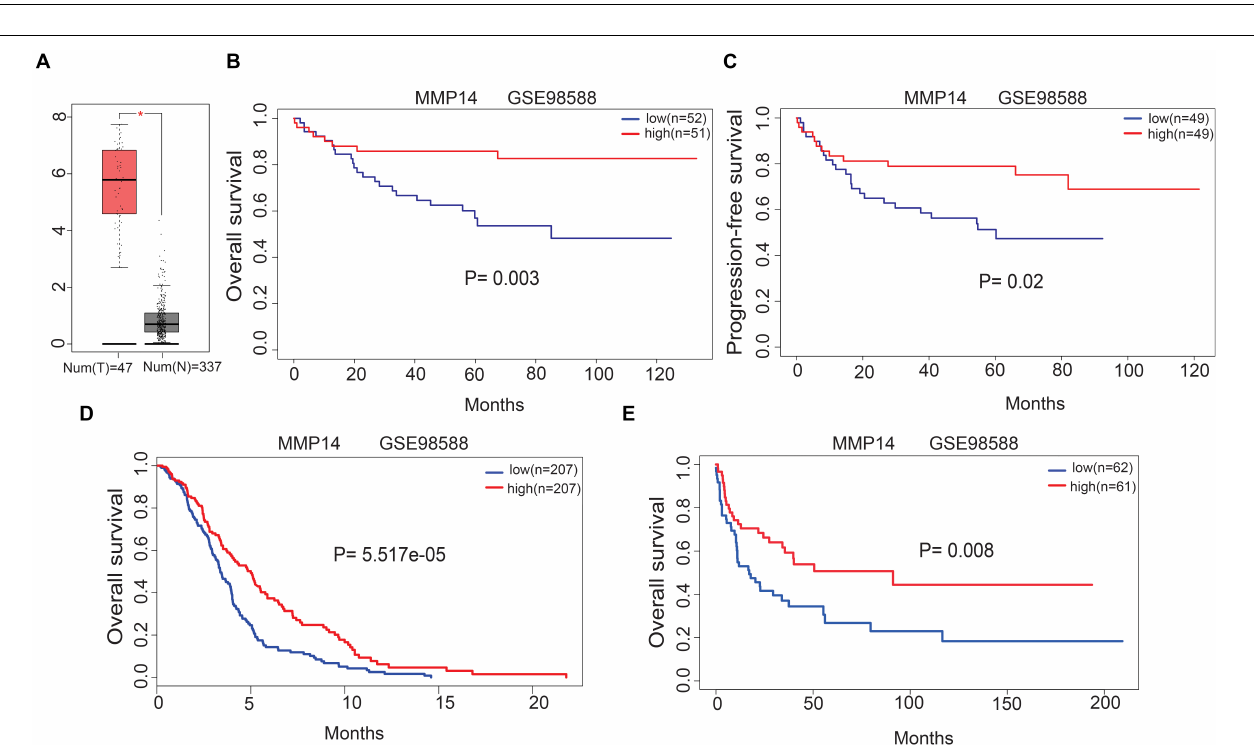
FIGURE 1 | (A) Venn diagram of overlapping differentially expressed genes in GSE10846 and GSE98588 diffuse large B-cell lymphoma (DLBCL) datasets. (B) Functional enrichment of overlapping genes based on Gene Ontology (GO) and Kyoto Encyclopedia of Genes and Genomes (KEGG) analyses.